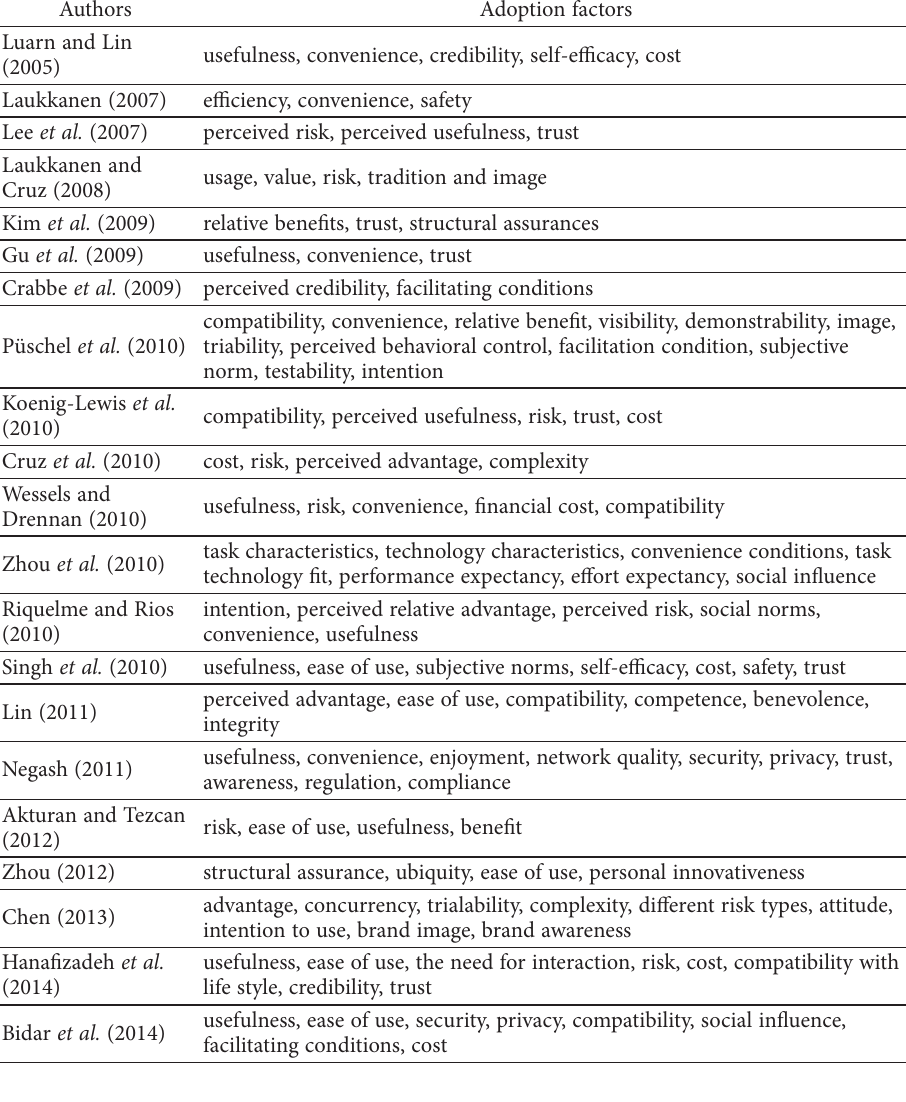
Table 1. Recent studies on M-banking adoption Authors Adoption